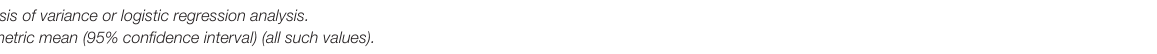
“Sweets” dietary pattern score “Animal foods” dietary pattern score